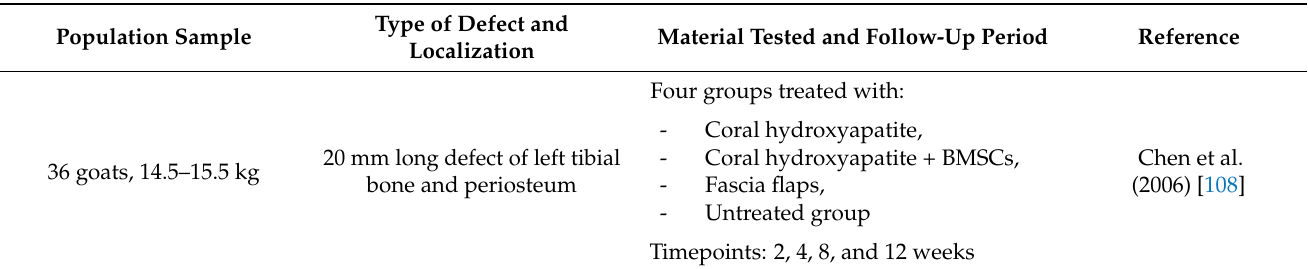
Table 3. MSCs studies in the caprine model for bone fracture and defect repair. Type of Defect and Population Sample Material Tested and Follow-Up Period Reference Localization